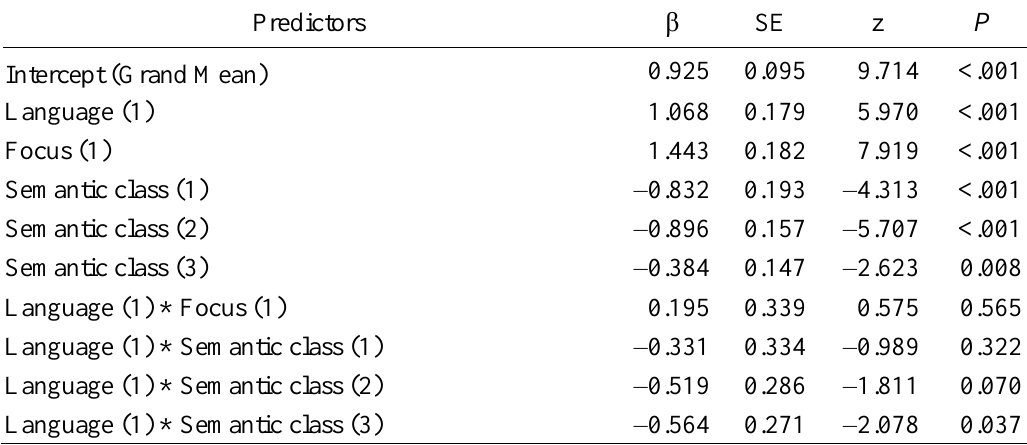
Table 6 . Fixed Effects Estimates of the generalized linear mixed